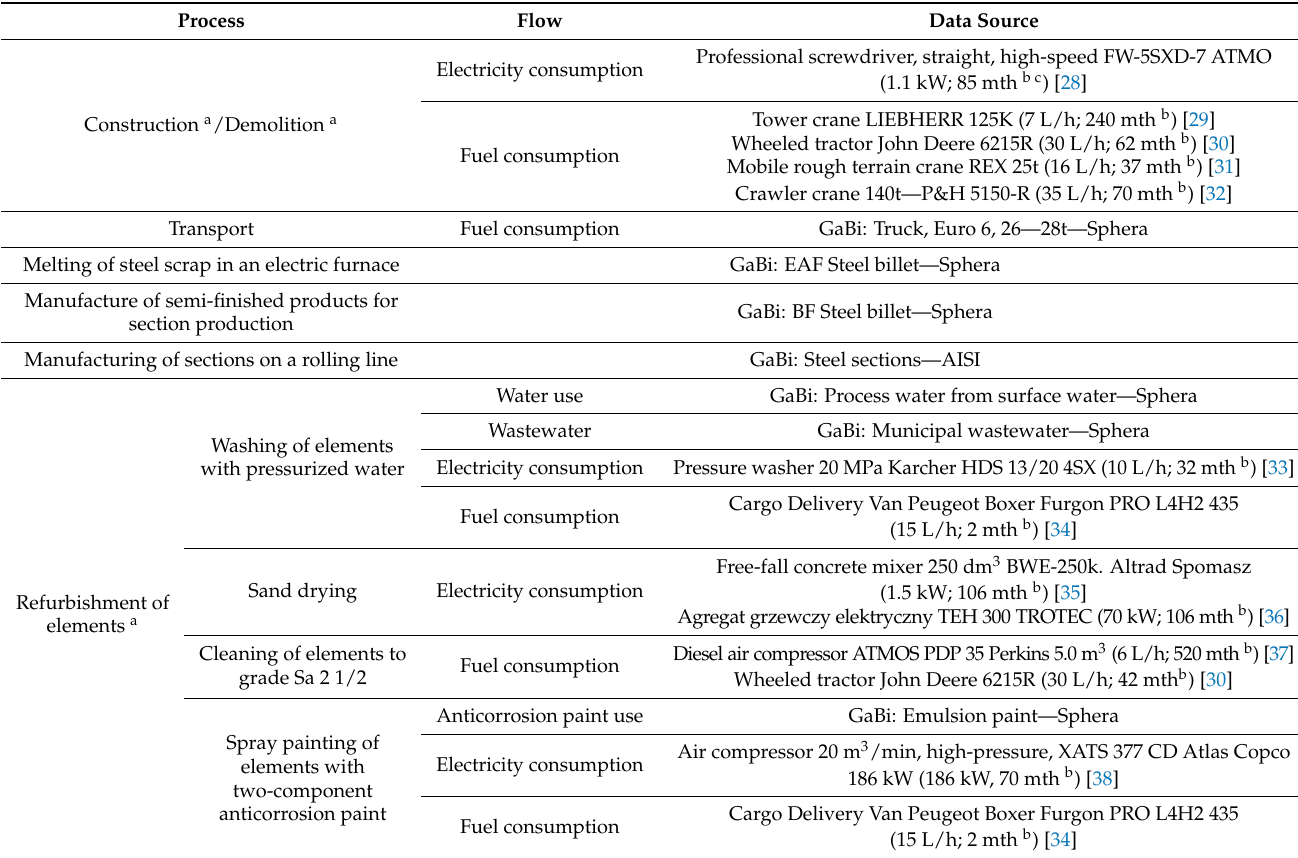
Table 3. Data sources for